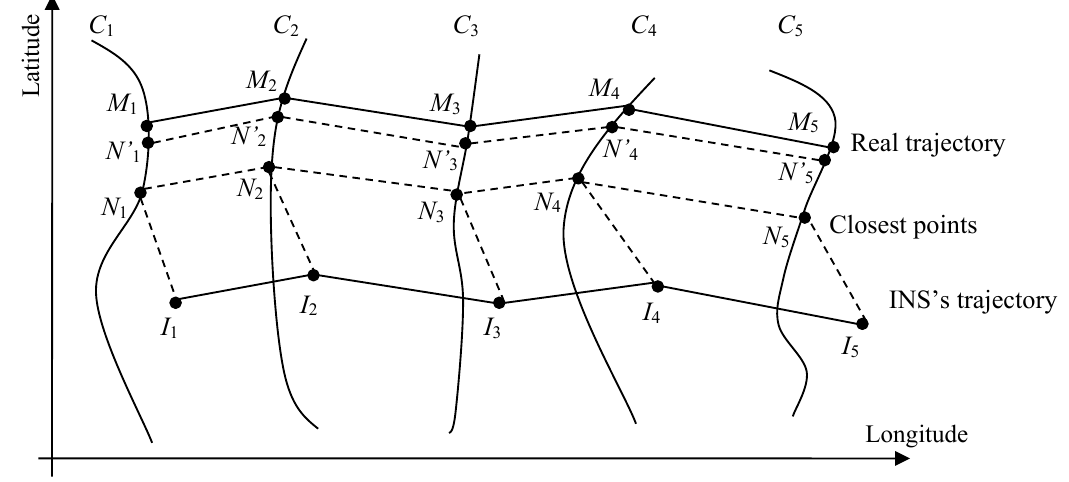
Figure 1. Basic principle of ICCP algorithm.